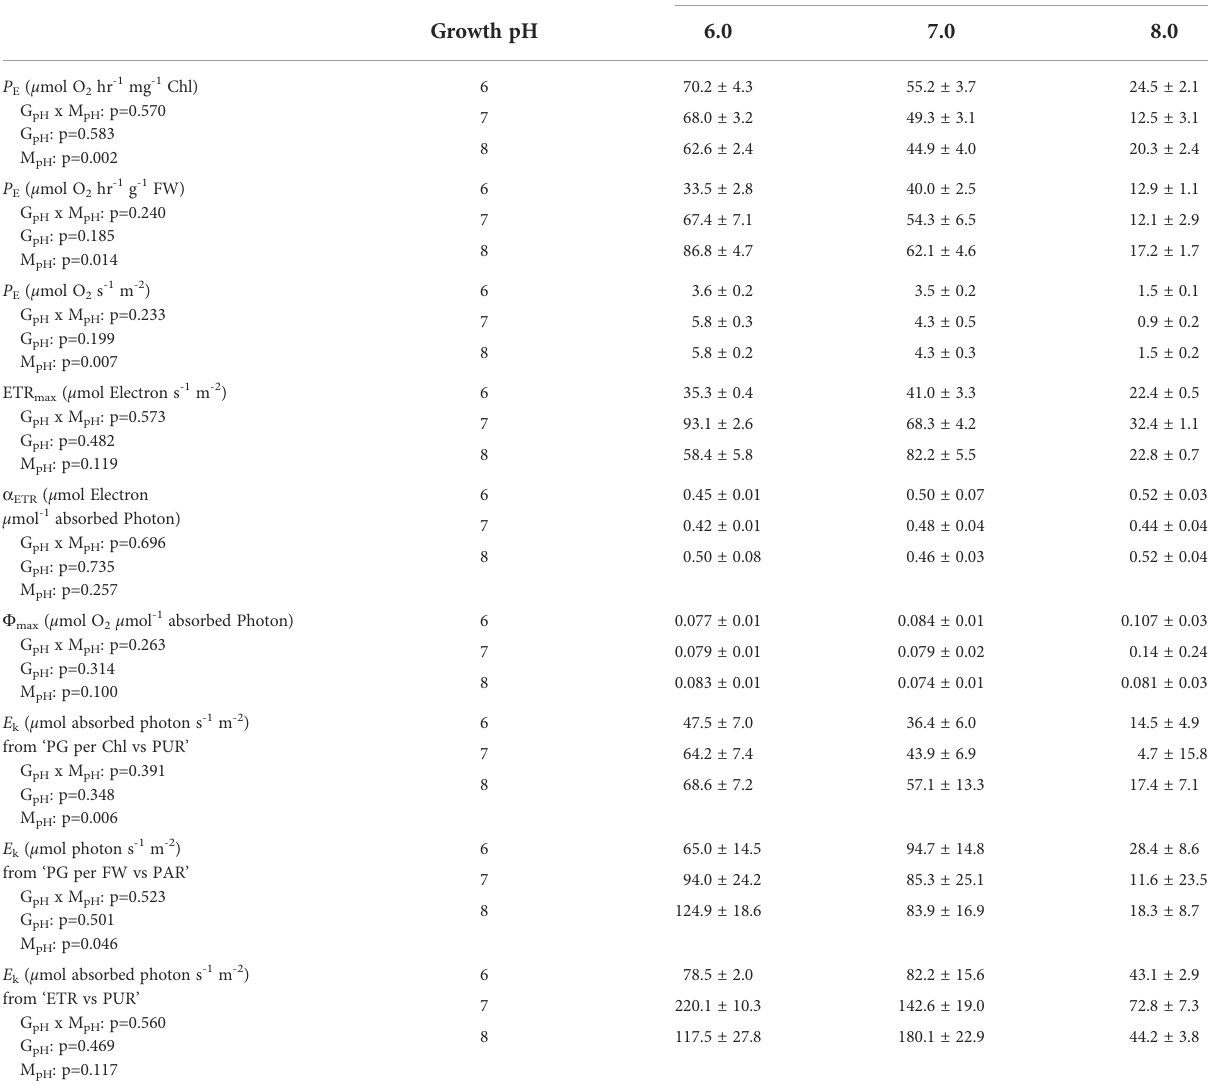
TABLE 5 Model estimates (mean ± 1 SE) of photosynthesis parameters generated by non-linear regression fi t to the experimental data using Equation (2) (N.S. stands for non-signi fi cant parameter estimate). Model